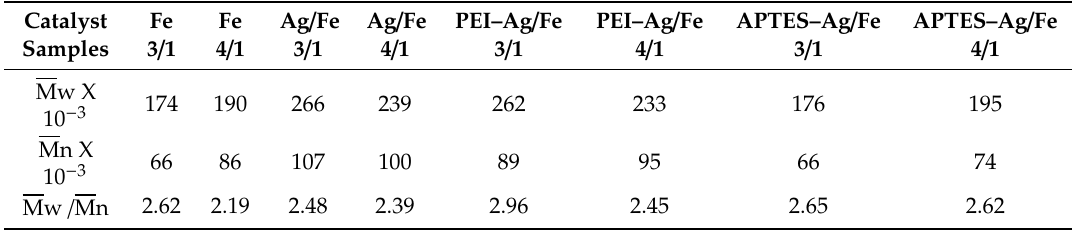
Table 2. Gel permeation chromatography (GPC) analysis of poly(methyl methacrylate) (PMMA) produced by solution polymerization using Cat. / B.P = 3 / 1 and 4 / 1 at 80 ◦ C for 3 h in an oxygen